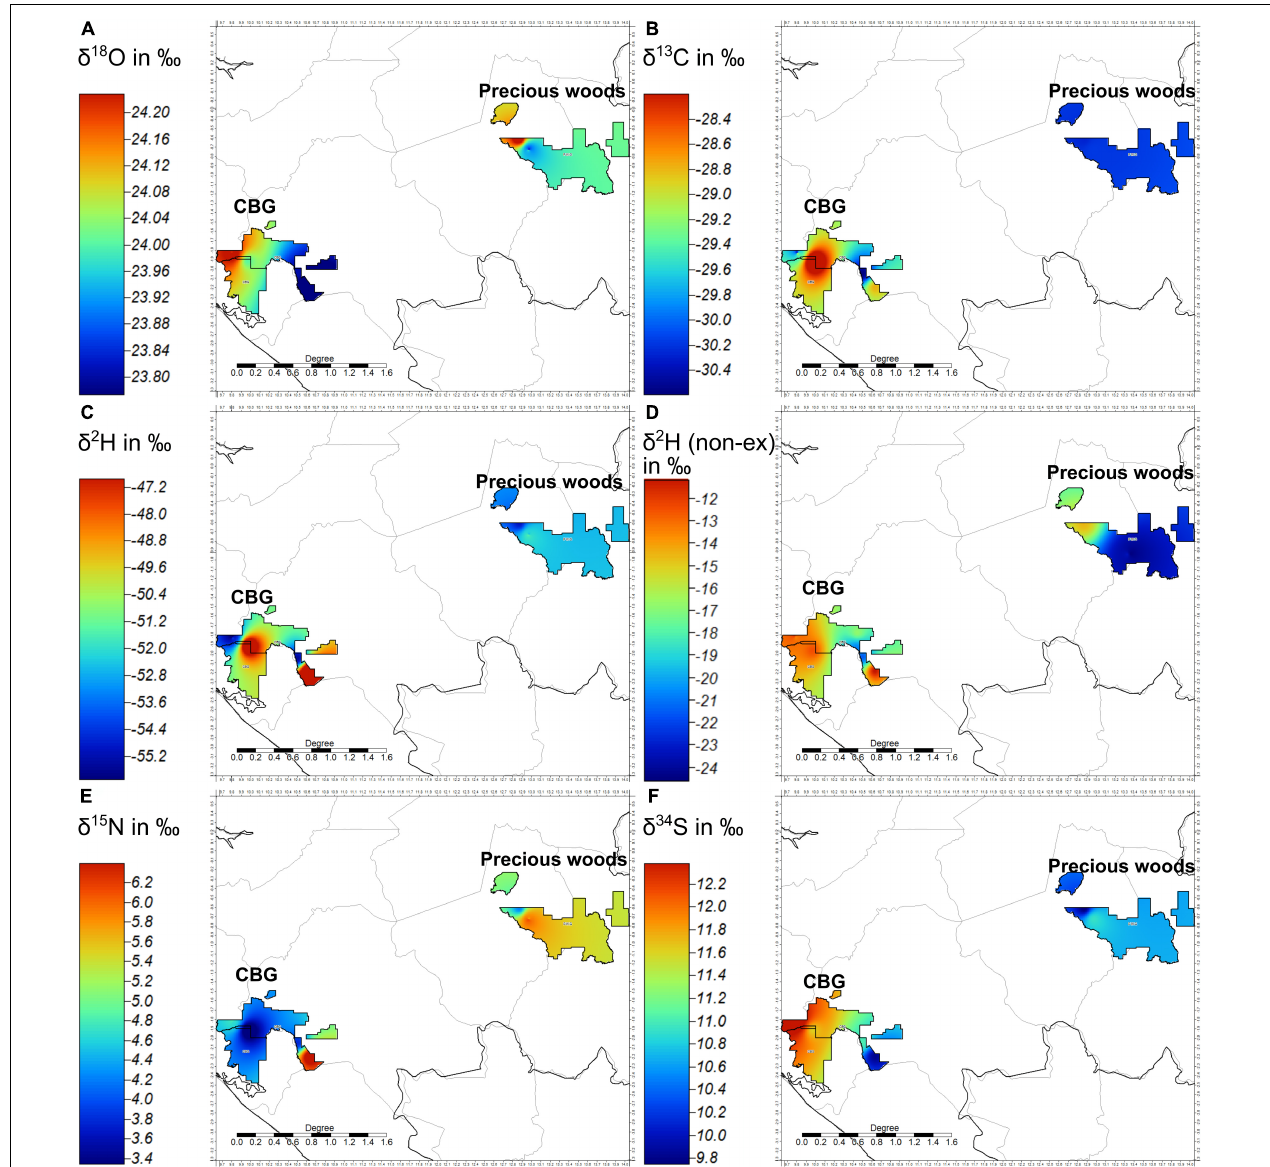
FIGURE 7 | Inverse distance weighting (global) isoscapes of Dacryodes buettneri stable isotope data (A) δ 18 O, (B) δ 13 C, (C) δ 2 H, (D) non-exchangeable δ 2 H from cellulose, (E) δ 15 N, (F) δ 34